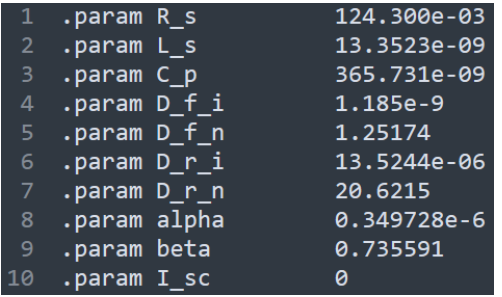
Figure 16. An example of a text file, which includes the necessary FCPVM parameters (for the large PV module, in this case), which is imported by LTspice once per simulation run.